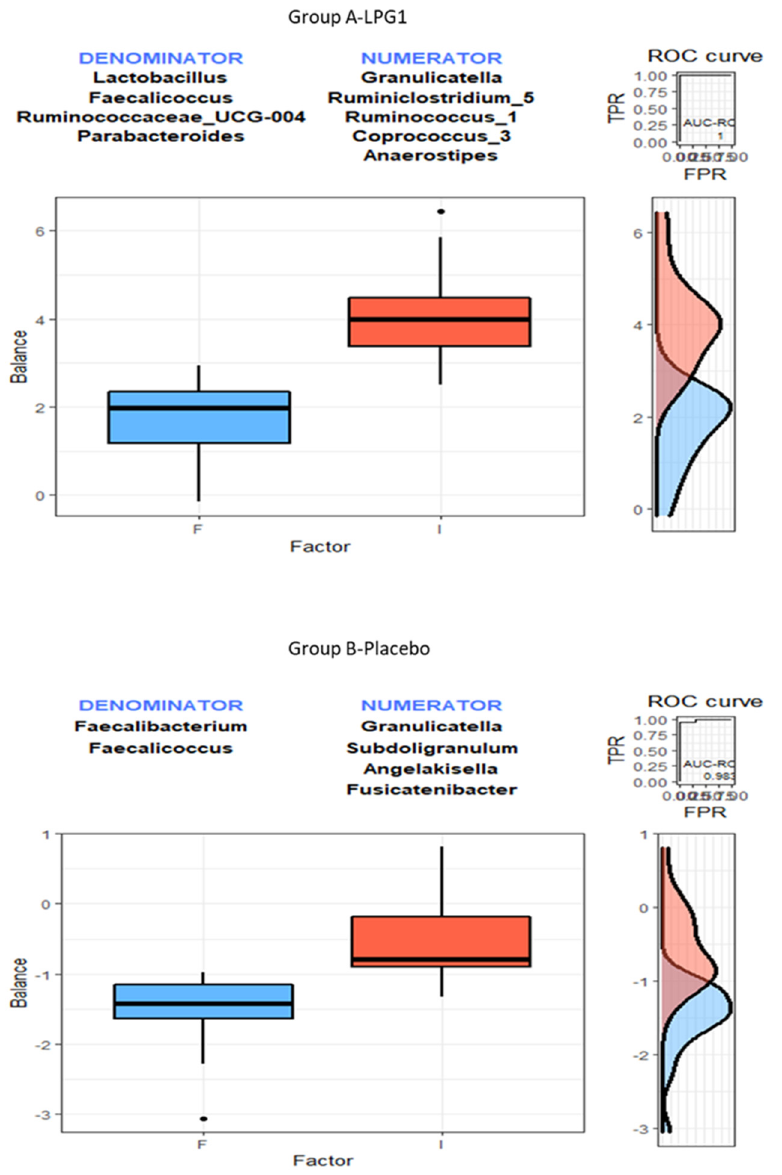
Figure 3. Boxplots and distribution curves of the balance scores selected by the selbal package (as shown in Table 3) generated from the gut microbiome data for each group included in the random- ised, placebo-controlled, single-blind trial. The balance scores allowed for distinguishing between samples from the initial (I) and final (F) phases in A—LPG1 but were less effective for the B—pla- cebo group (ROC values). Notably, the Lactobacillus genus was included in the balance for segregat- ing the initial and final phases in the A—LPG1 group but was absent from the balance for the B— placebo